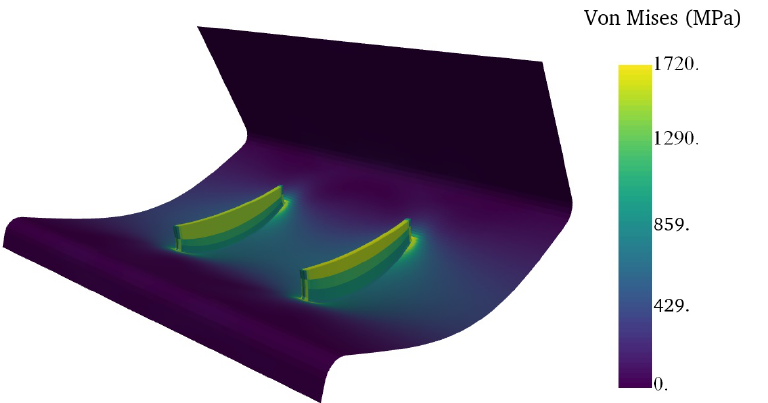
Figure 4. Final state related to an 8-unitary operations sequence (displacements ×